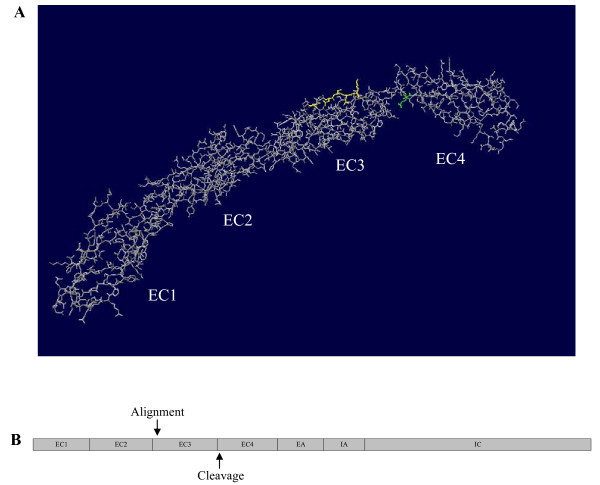
Structure of the porcine desmoglein 1 gene and gene product. A, The four extracellular domains (EC1-4) of the porcine desmoglein 1. (PIG)DSG1 is modelled on top of the crystal structure of C-cadherin. The 3D structure indicates that the cleavage site is situated between EC3 and EC4 [7] (green). The amino acids of the important loop in human sequence is also in the porcine structure placed on a loop on the opposite side of EC3 (yellow) [8]. B, The arrangement of the porcine desmoglein 1 protein. The cleavage site and the putative alignment motif are marked with arrows in the extracellular domains. EA: Extracellular anchor domain, IA: Intracellular anchor domain, IC: Intracellular domain. [7]